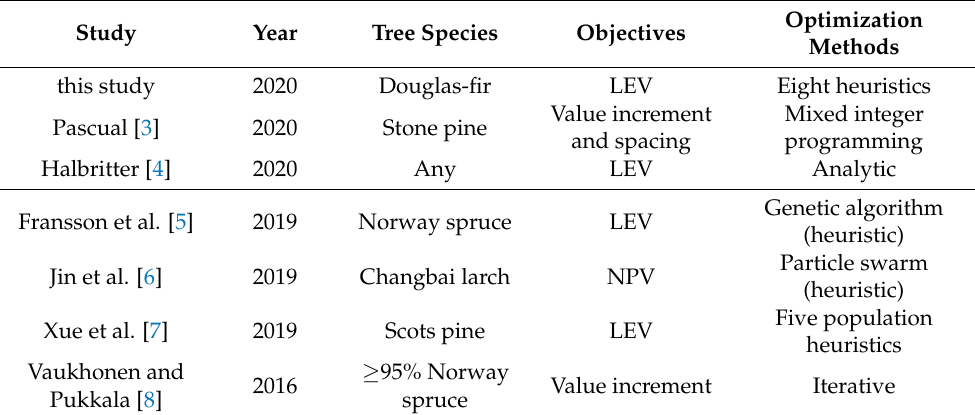
Table 1. Comparison of this study to other recent investigations of thinning optimization. The authors of Ça˘glayan et al. and Yoshimoto et al. [2,11] non-exhaustively surveyed an additional 182 studies of optimal management from 2016 and